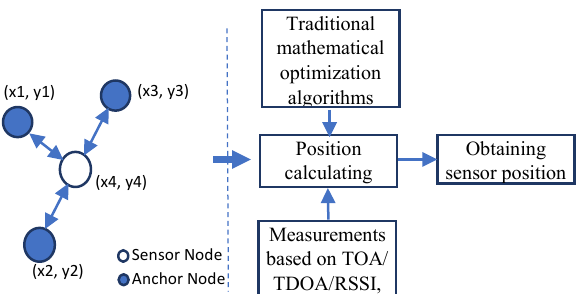
Figure 1. Anchor-based sensor nodes localization approach using traditional mathematical optimization algorithm WSNs